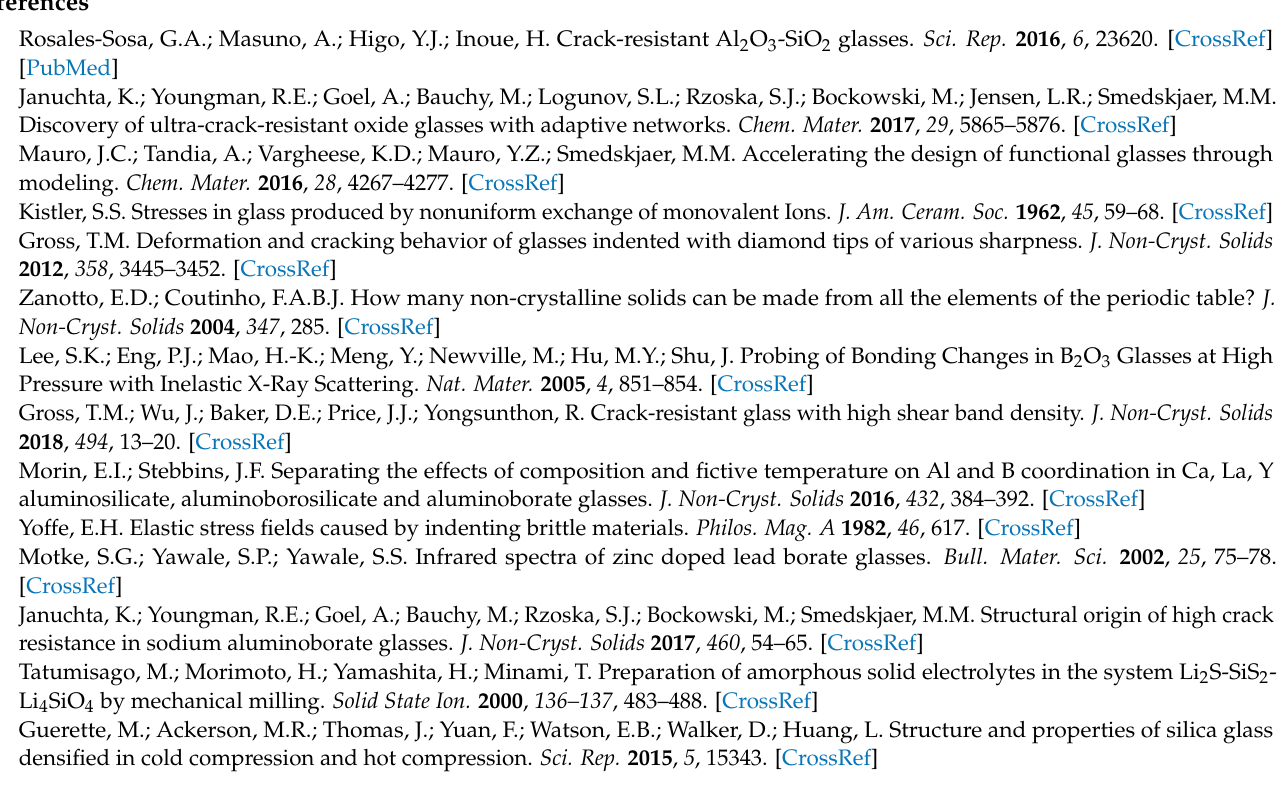
(CR). Table S2: Atomic packing density ( C g ) of the as-made, hot compressed, humid aged,